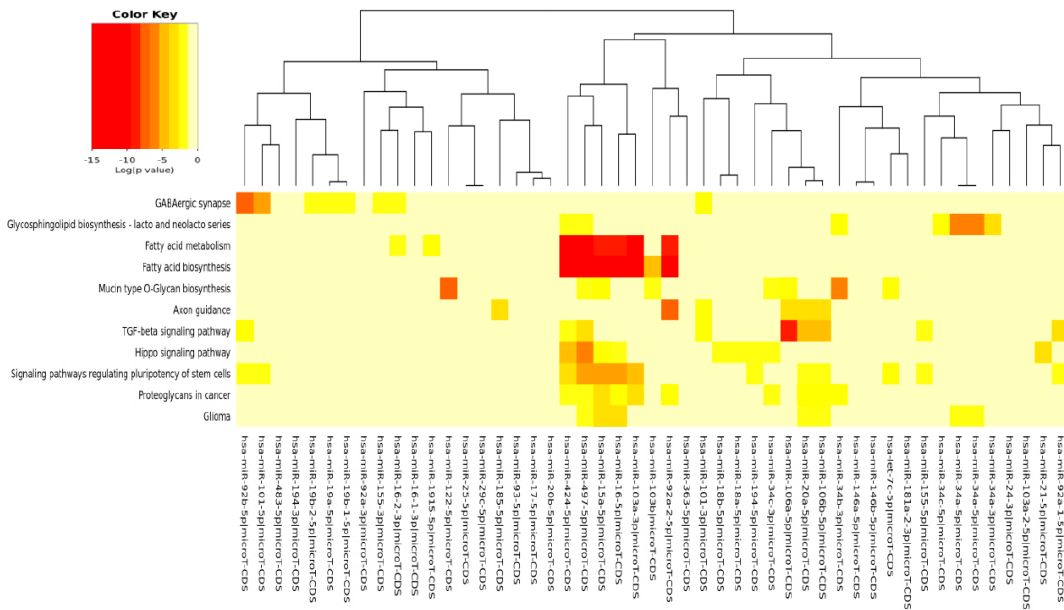
Figure 4. MicroRNAs involved in DDR and modulated by CRC versus the pathways’ heat map. In this plot, heat map calculation is based on absolute p -values. Darker colors represent lower p -values (higher significance). The plot shows microRNAs targeting similar pathway clusters and pathways being targeted by miRNA groups.